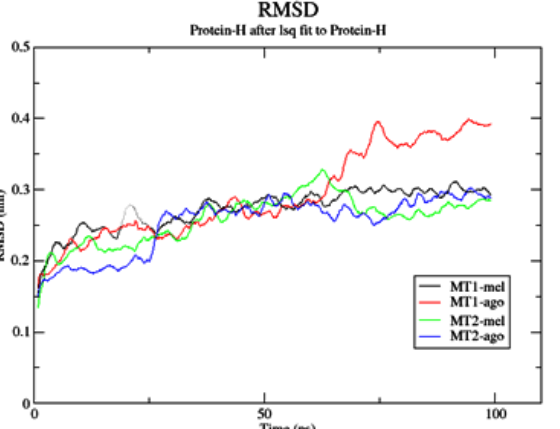
Table 1. Free Gibbs binding energies ( Δ G bind ) associated with the docked poses are reported in Figure 6.